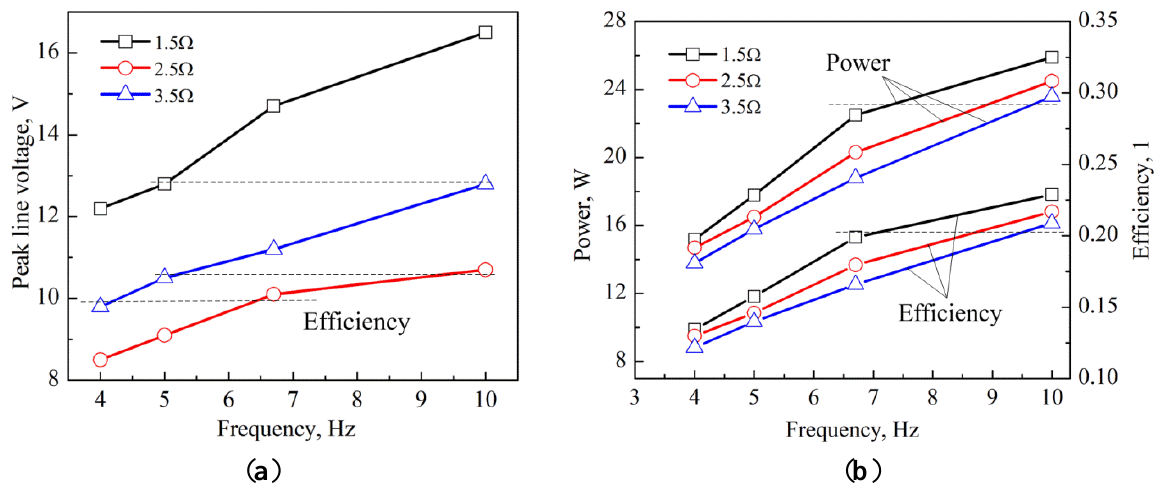
Figure 11. ( a ) The peak line voltage at different frequencies; ( b ) The generated power and efficiency at different frequencies.